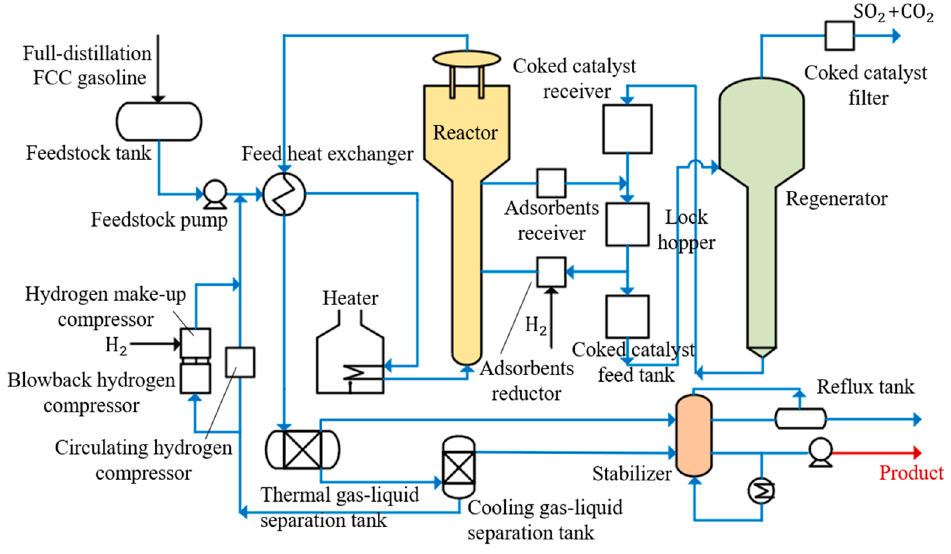
Figure 5. Process graph of an S-Zorb unit.